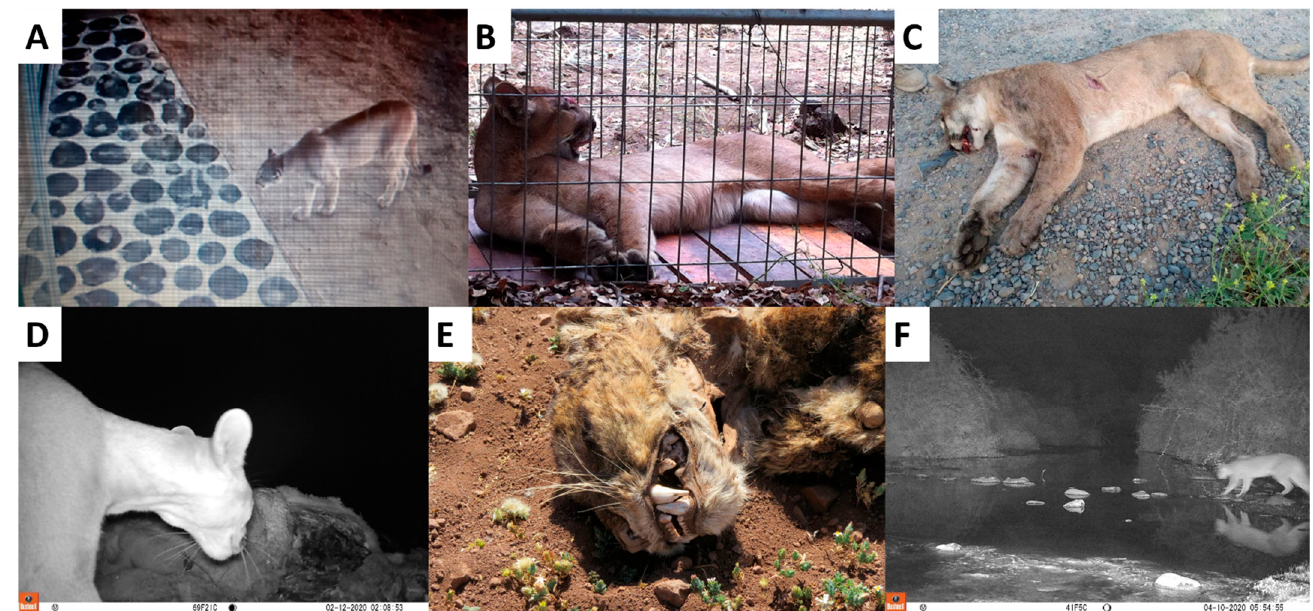
Figure 2. Records of P. concolor across the O’Higgins region in central Chile (selection). Different types of evidence are shown: Security cameras ( A ), trail camera photographs ( D , F ), live captures ( B ), and corpses found ( C , E ). Letters correspond to sites referenced in Figure 3.